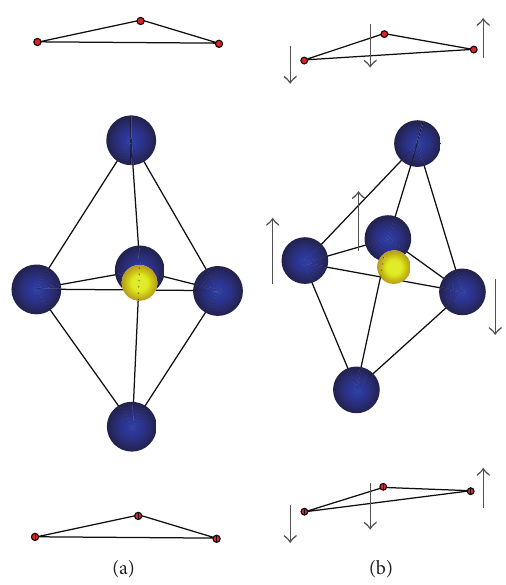
Figure 2: Schematic of MnO 5 bipyramid above and below 𝑇 𝐶 , respectively. (a) Centrosymmetric structure with space group 𝑃6 3 /mmc and (b) noncentrosymmetric with The arrows indicate atomic displacements with respect to the centrosymmetric structure [14, 30]. (Red: Re, blue: O, yellow: